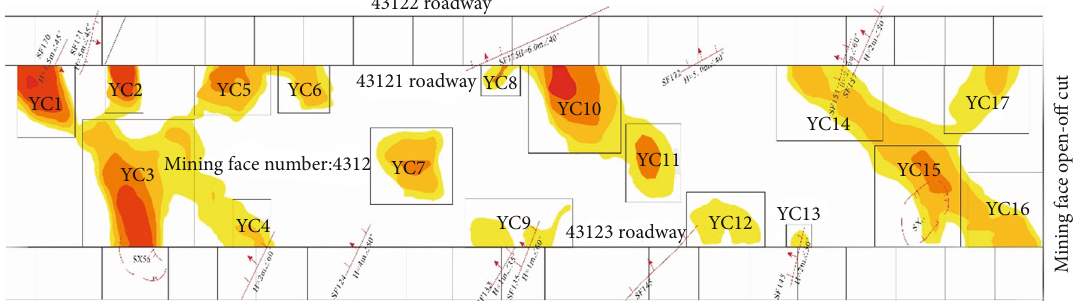
Figure 1: Detection results of geological